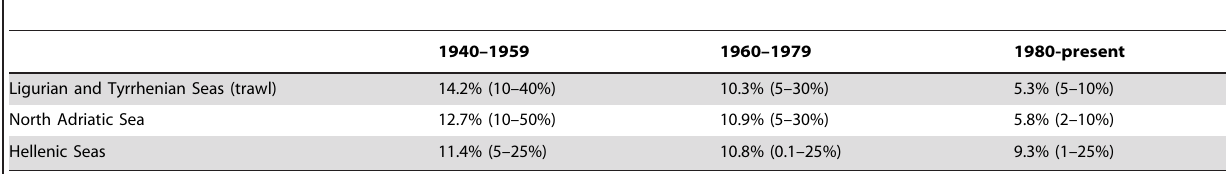
Proportion as % of catch in weight (average and min-max values between brackets) according to the interview survey results in case studies in which fishers could readily separate cartilaginous fish from bony